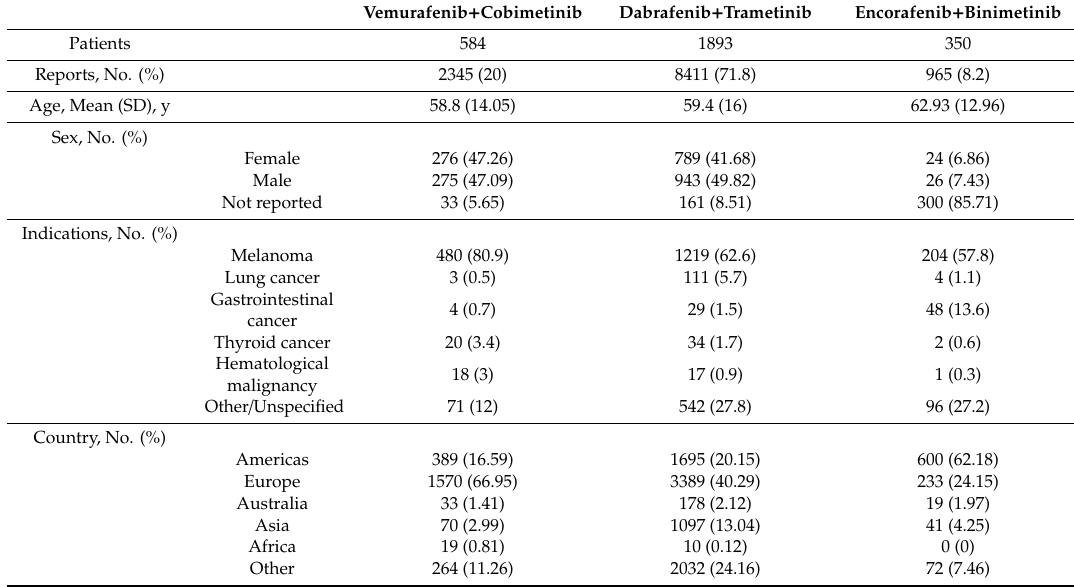
Table 1. Characteristics of patients with BRAF + MEK-associated adverse